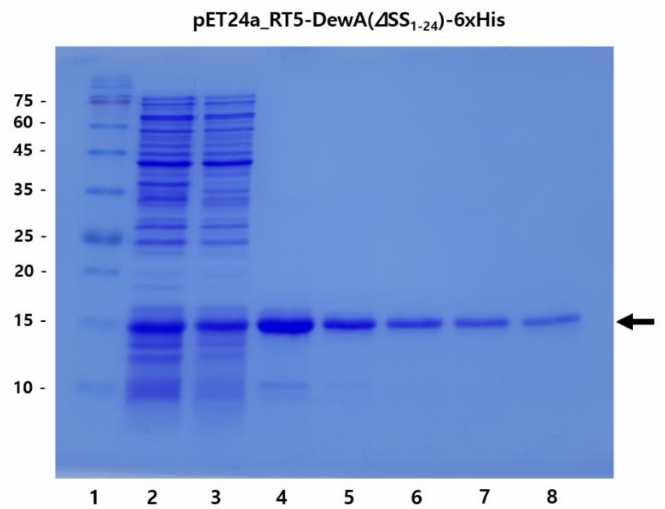
Figure 3. SDS-PAGE analysis of recombinant hydrophobin DewA purified by ATPS using IPA. Lane 1, protein size marker; 2, total fraction; 3, soluble fraction; 4, final white precipitate solubilized in 1 mL of 200 mM Tris-HCl buffer (pH 8.0) buffer following purification; 5–8, samples obtained by sequential dilution of previous sample (lane 4) with 1 mL of the same buffer. The arrow indicates the purified RT5-DewA( ∆ SS 1-24 )